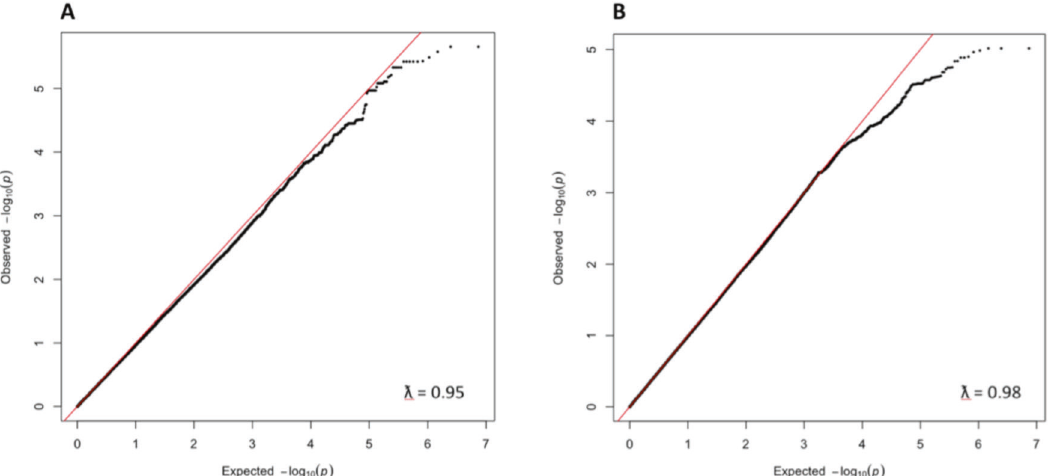
Fig. 4 Quantile – quantile (Q – Q) plots from the GWAS study. Q – Q plots of SNPs for association to SOA25 ( A ) and SOA5 ( B ) in the data set consisting of 458 individuals. On the y-axis, the observed p -values (black dots) are plotted against the expected p -values under the null distribution. The straight red lines indicate the distribution of SNPs under the null distribution. Genomic in fl ation factor lambda ( λ ) are indicated in the bottom right